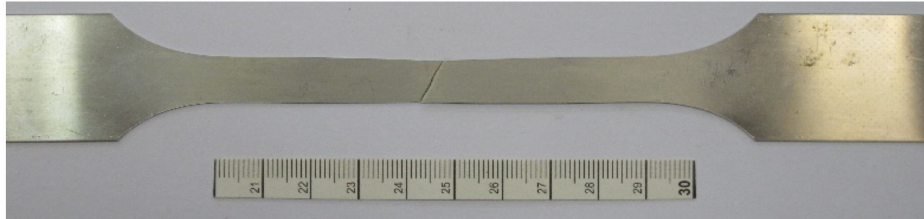
Figure 7. Specimen of the base metal taken in the rolling direction.